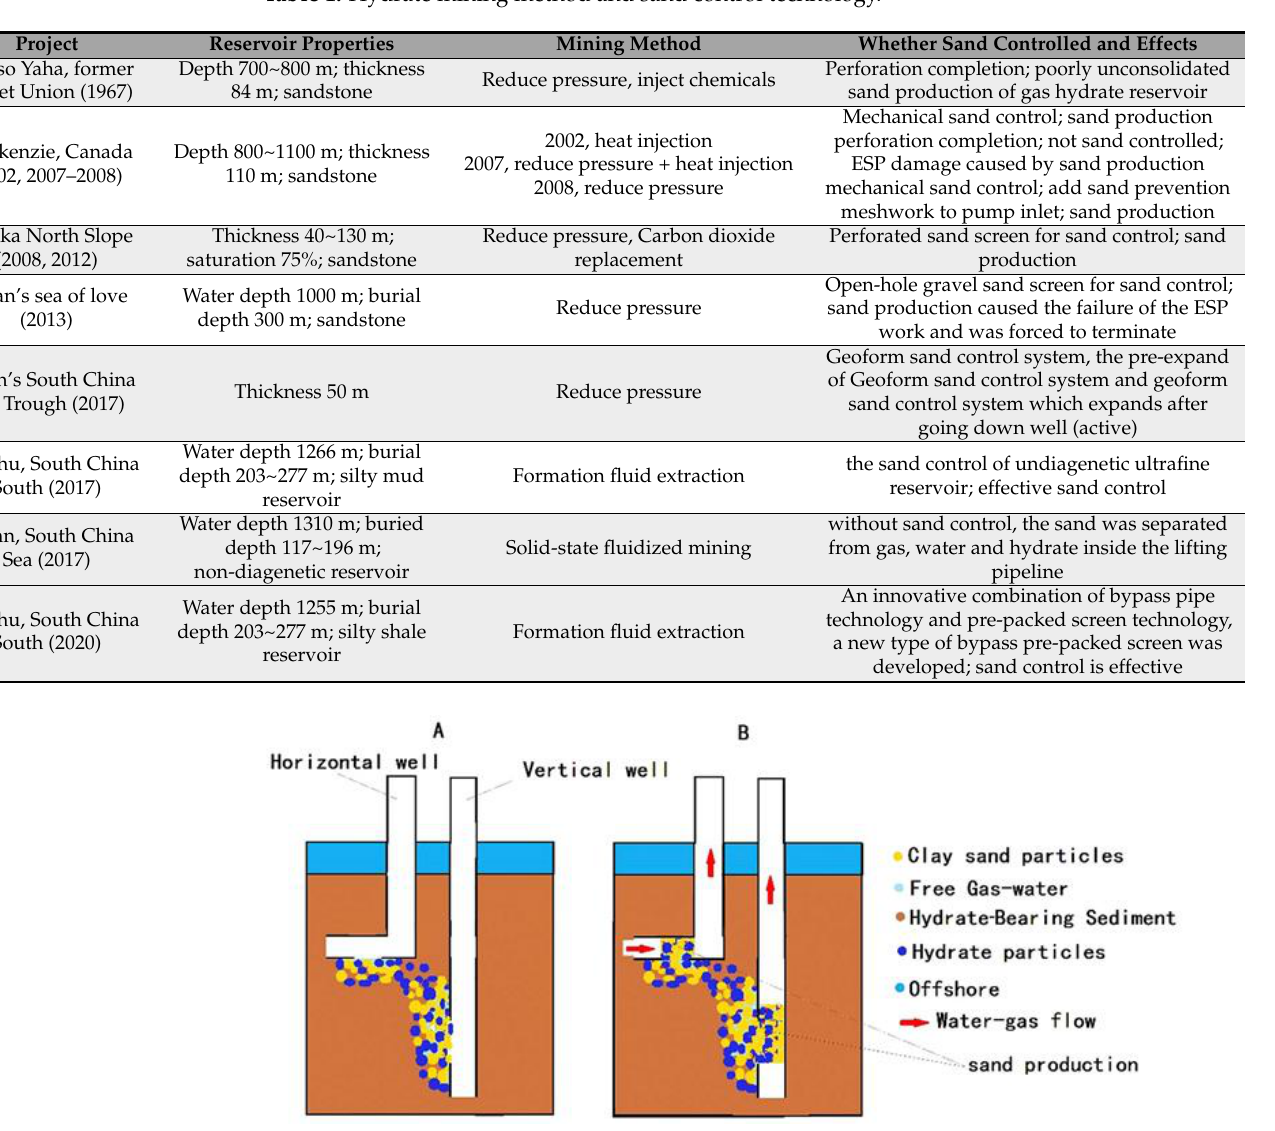
Figure 5. Schematic diagram of ( A ) hydrate-bearing sediment (exploitation in the horizontal and vertical wells) and ( B ) sand production during hydrate exploitation [This figure was modified with permission from ref [121]. Copyright 2021, American Institute of Physics].